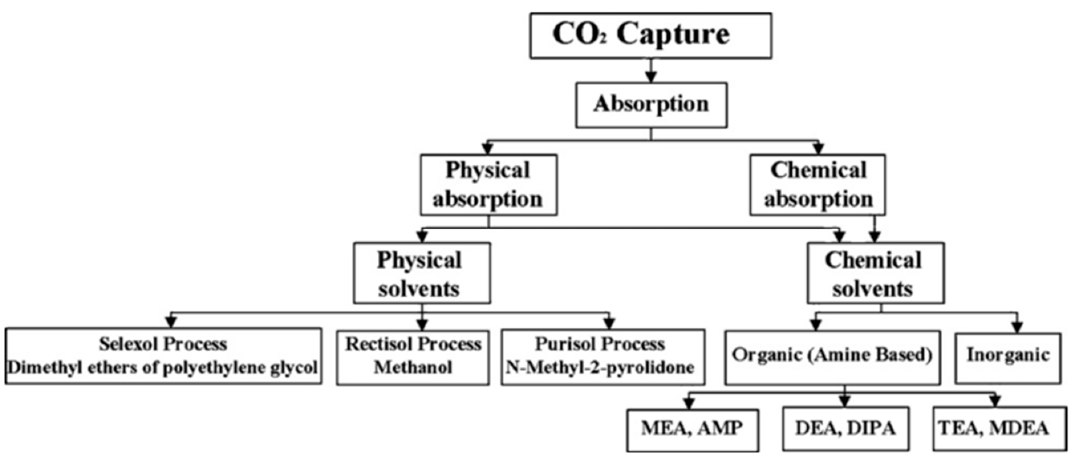
Figure 6. Classification of absorption processes for CO 2 capture [49].